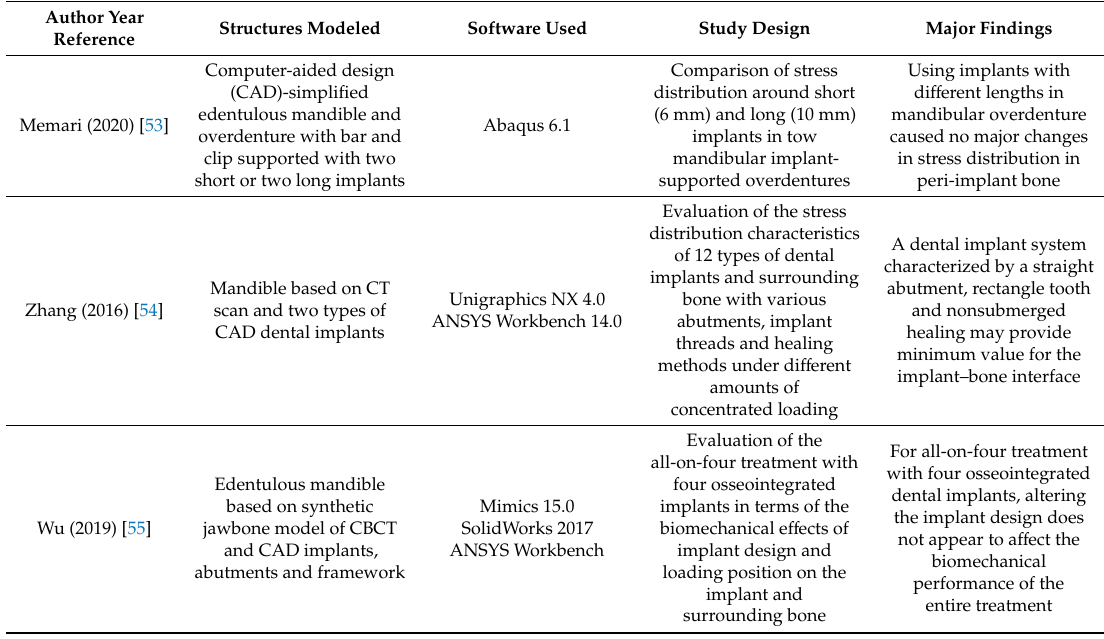
Table 4. Information regarding FEA conducted in the field of